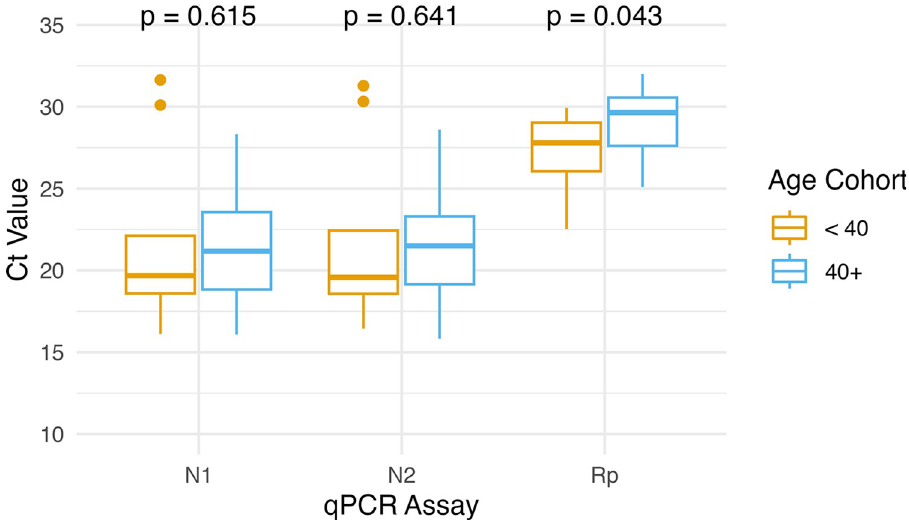
Fig 4. Comparison of mean Ct values between samples from patients over/under 40 years of age. Box and whisker plots showing mean Ct values for each qPCR assay, divided by age cohort as in Levine-Tiefenbrun [11]. Whiskers indicate maximum and minimum Ct value for each cohort. Horizontal line within box indicates mean Ct value. Significant (p < 0.05) Wilcoxon ranked-sum test significance values are listed as p-values above each assay. Dots indicate outlier